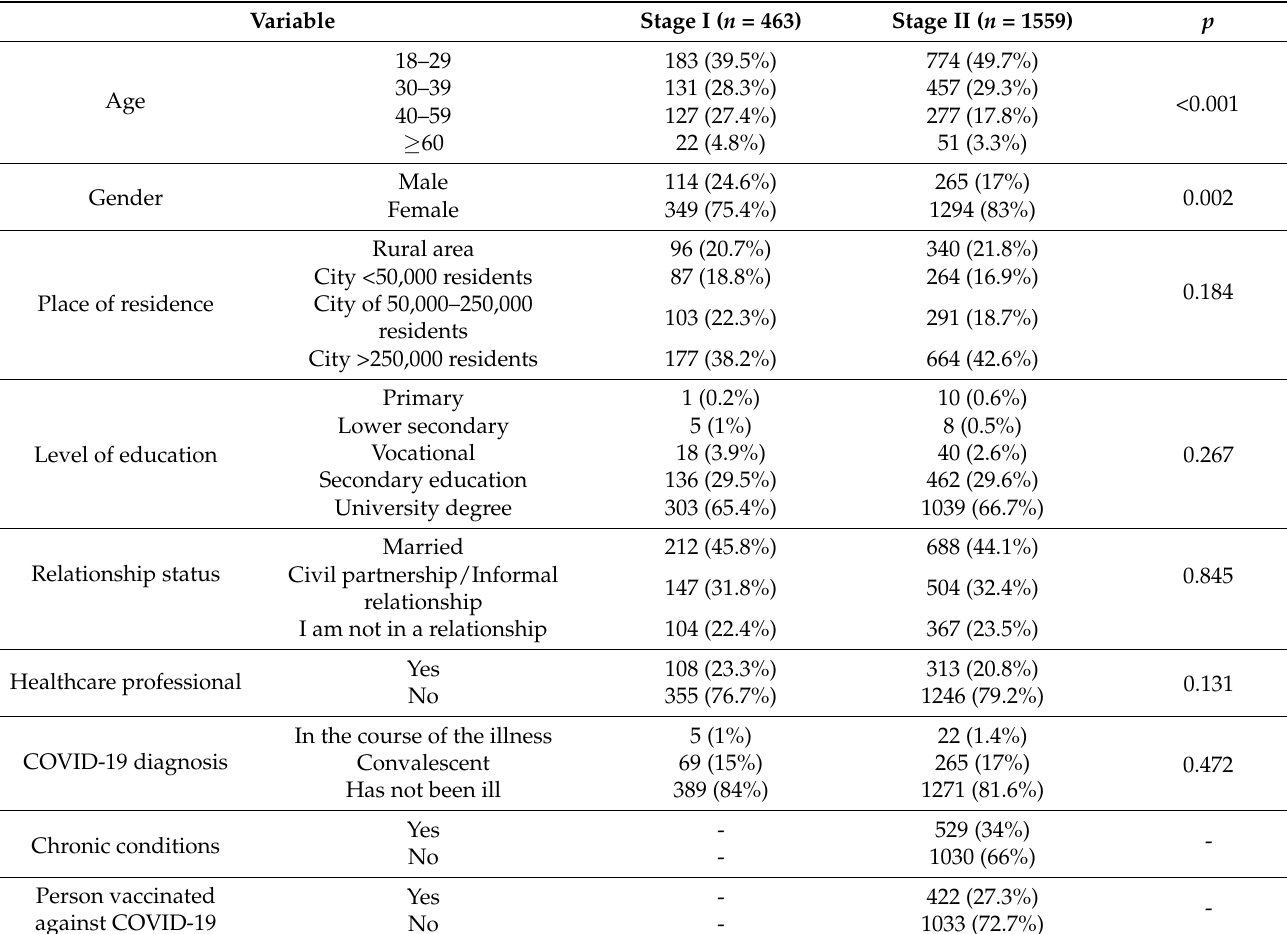
Table 1. Characteristics of the study group with regard to the stages of the